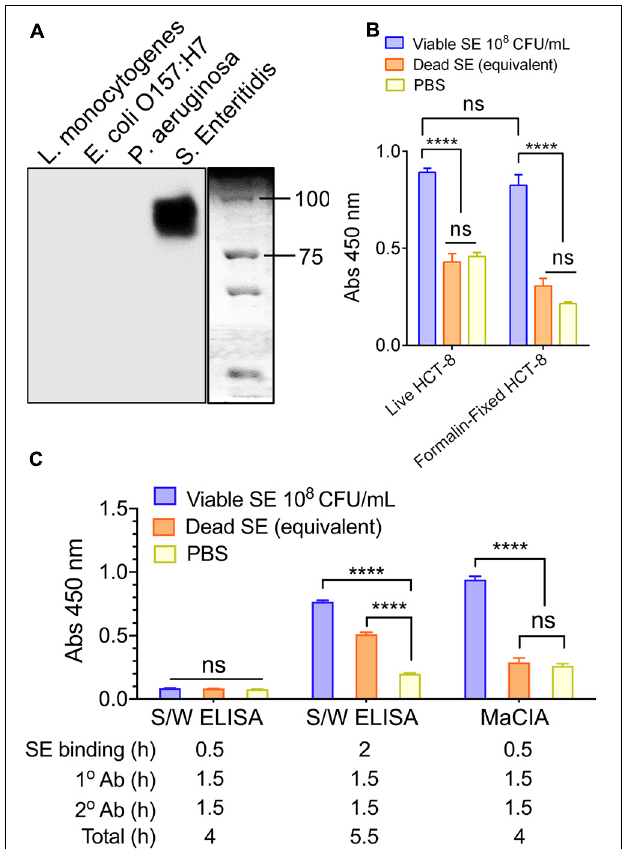
FIGURE 1 | Mammalian cell-based immunoassay (MaCIA) development. (A) Western blot showing the reaction of mAb-2F11 to Salmonella enterica serovar Enteritidis PT21 but not to L. monocytogenes F4244, E. coli O157:H7 EDL933 and Pseudomonas aeruginosa PRI99. (B) MaCIA analysis with live (Live HCT-8) and formalin-fixed (Formalin-fixed HCT-8) HCT-8 cell. (C) Comparison of MaCIA with sandwich ELISA (S/W ELISA). Error bars represent the standard error of the mean (SEM). **** P < 0.0001; ns, no significance. Cut-off for positive: P < 0.001. SE, S . enteritidis; Ab,